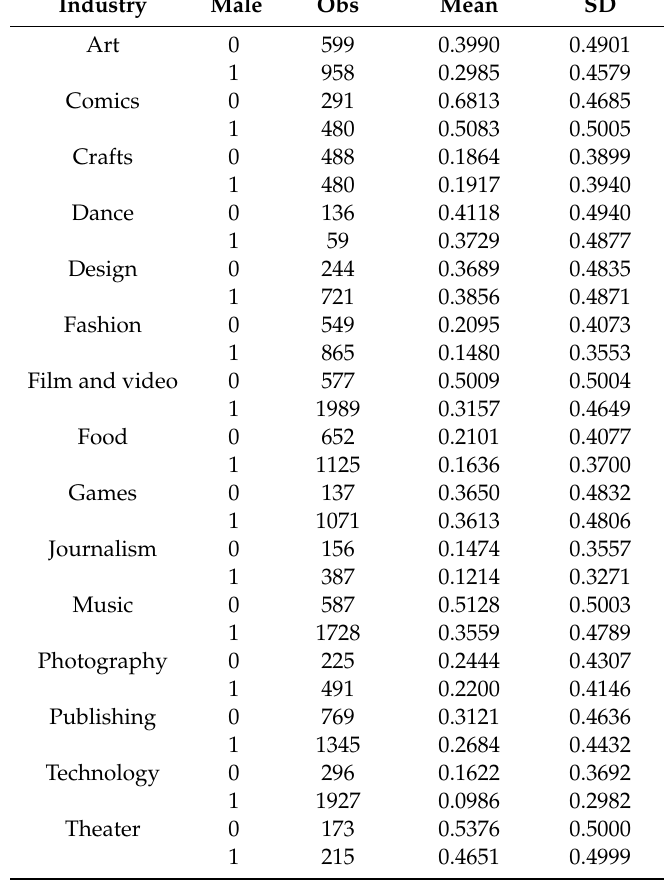
Table 1. Individual projects by gender. This table provides the success rate of projects by gender in di ff erent industries.